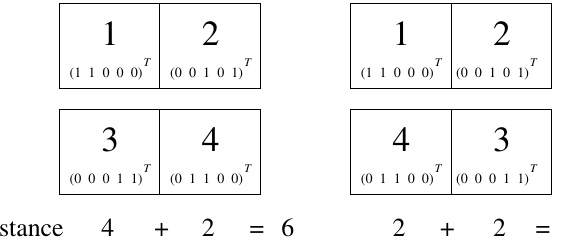
Figure 6. Normalization with Hamming distance in the example from Figure